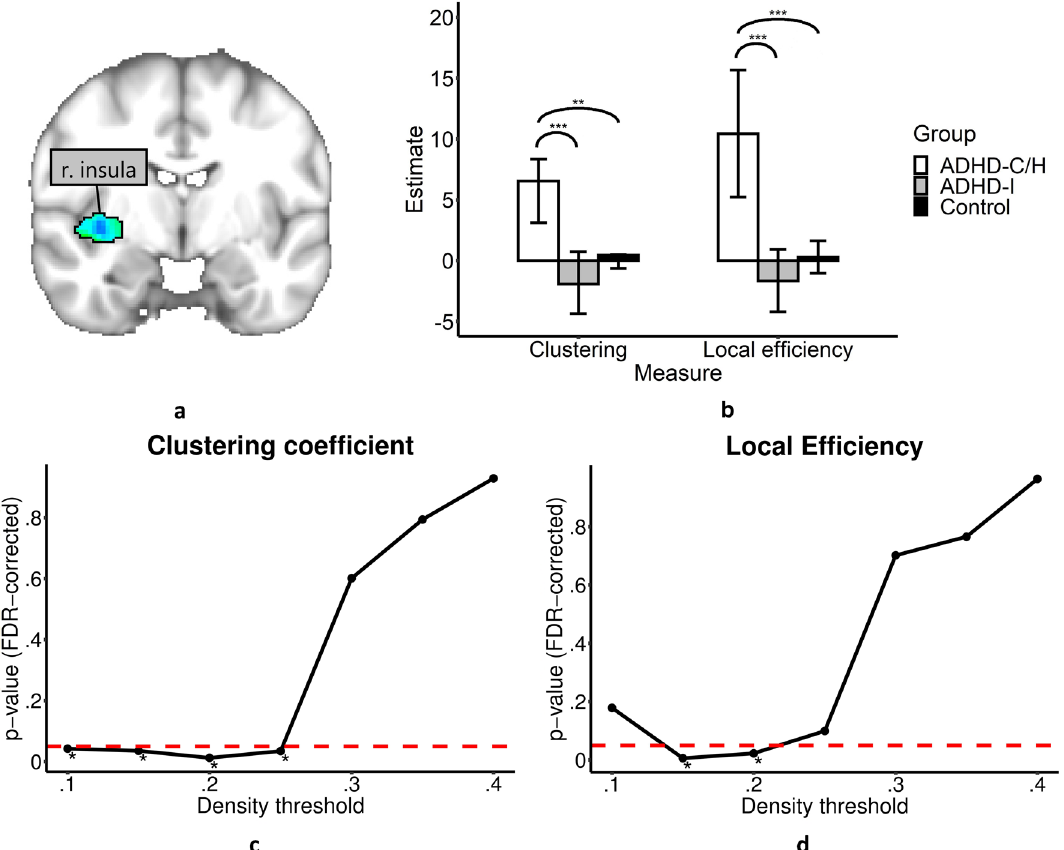
Figure 1. Brain nodes whose nodal network properties are associated with emotional dysregulation in young adult participants with ADHD. Results are shown for the latent variable in relation to local efficiency and clustering measures of the right insula. ( a ) The right insula showed a significant association with emotional dysregulation. Here the underlying parcel is shown. ( b ) Group-specific parameter estimates for the relation between the emotional latent variable and the topology measures (density-integrated) significantly differed between the participants with ADHD-I and ADHD-C/H as well as between participants with ADHD-C/H and controls. 95% confidence interval are displayed. Asterisks give significant group-specific differences (as calculated with χ 2 difference tests) of the corresponding post-hoc two-group SEM (*** p < 0.001, ** p < 0.01, * p < 0.05, n.s. p > 0.05; ADHD-C/H: attention-deficit/hyperactivity disorder, combined or predominantly impulsive/hyperactive attention-deficit/hyperactivity disorder; ADHD-I: predominately inattentive attention- deficit/hyperactivity disorder). ( c , d ) Group-specific differences in the relation between the latent variable and topology measures exist across graphs with different density thresholds (below 0.25). p -values of the χ 2 difference tests are shown. Asterisks signify significance after FDR-correction. The dashed red line represents p = 0.05. Figure ( a ) was created using FSLeyes (version 0.22.6, https:// fsl. fmrib. ox. ac. uk/ fsl/ fslwi ki/ FSLey es). Figures ( b , c , and d ) were created with R software (version 3.6.0, https:// cran.r- proje ct.